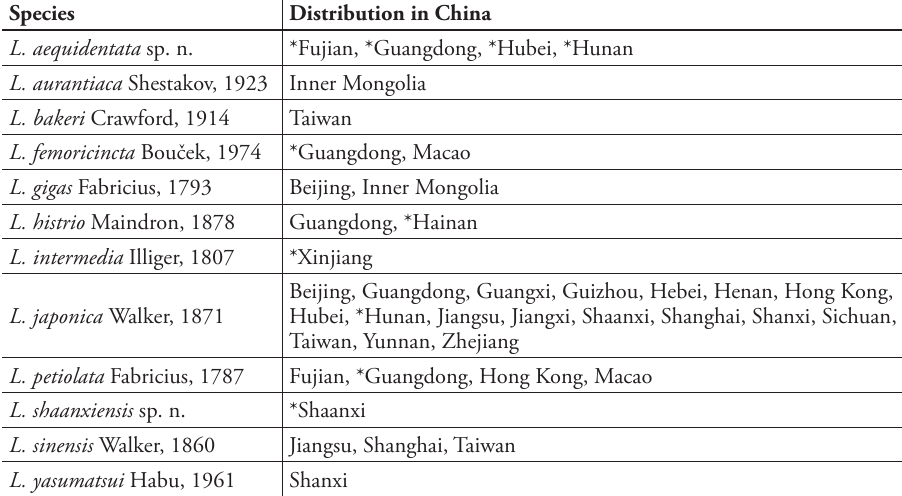
Table 1. Revised checklist and known distribution of Leucospis species in China. An asterisk indicates a new